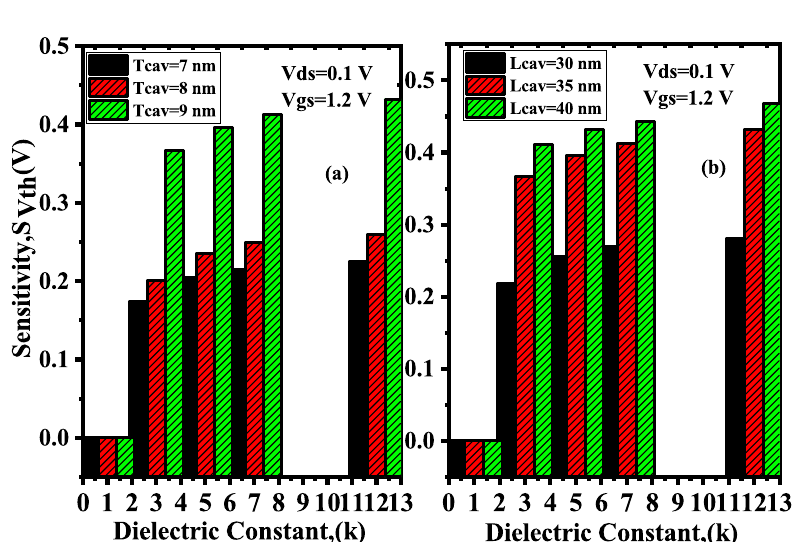
Figure 11. Sensitivity of the device for ( a ) Variation in cavity thickness ( b ) Variation cavity length (